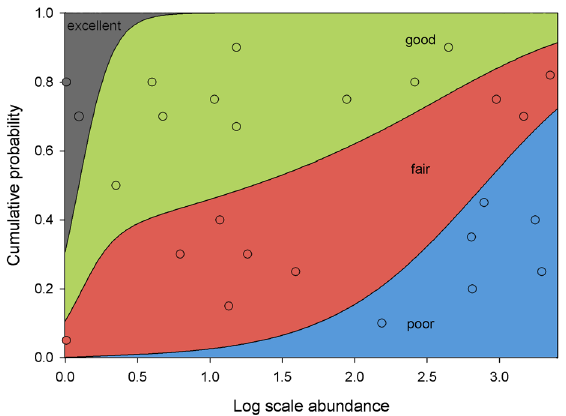
Figure 4. Since scale insect abundance was the most important predictor in our multiple logistic regression model, we use simple logistic regression to illustrate the relationship be- tween scale insect abundance and tree condition. Points represent recorded measures of M. tenebricosa abundance on the x- axis but are not associated with y-axis cumulative probabilities. Colored sections are associated with the cumulative probabilities on the y-axis as they change across measured M. tenebricosa abundance on the